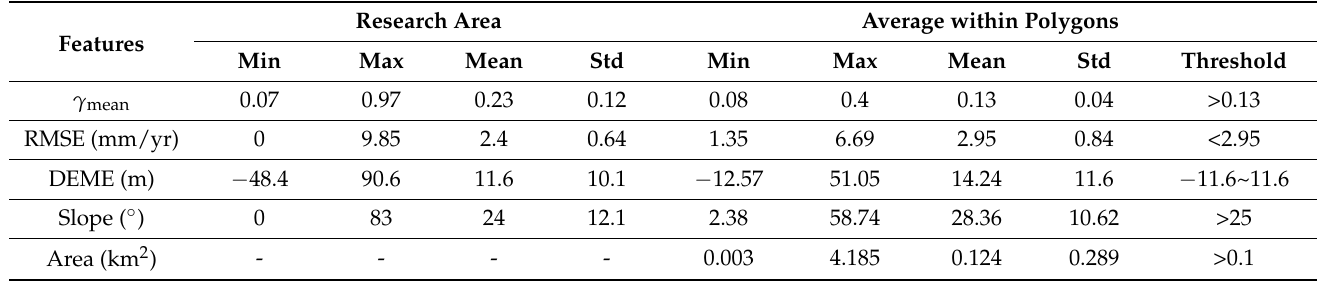
Table 2. Data statistics and threshold parameters.